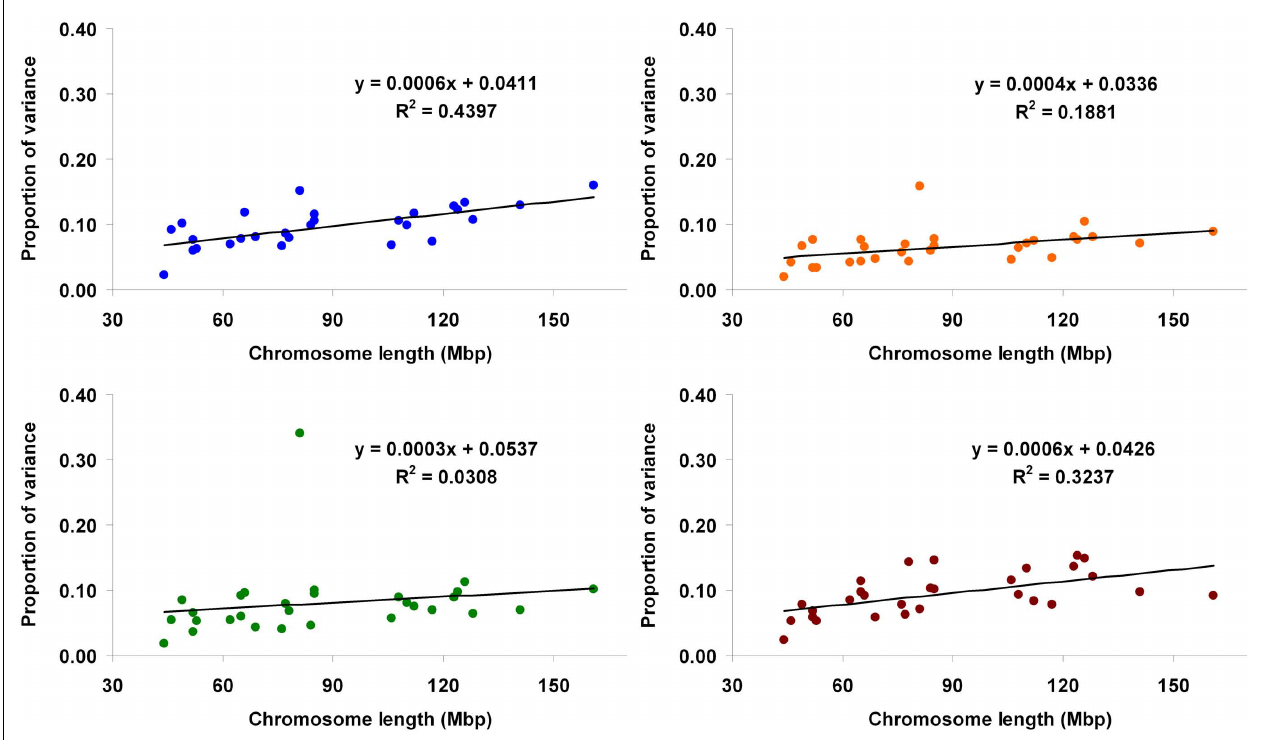
FIGURE 3 | Proportion of genetic variance for milk yield (blue), protein percentage (orange), fat percentage (green), and somatic cell score (brown) explained by each autosome (estimated using method 2) against physical length of the